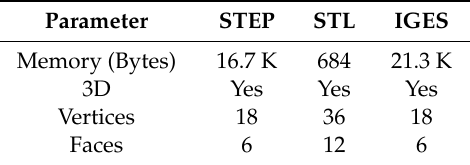
Figure 2. A cube model (10 × 10 × 10 mm 3 ). Table 1. Comparison of different CAD file formats